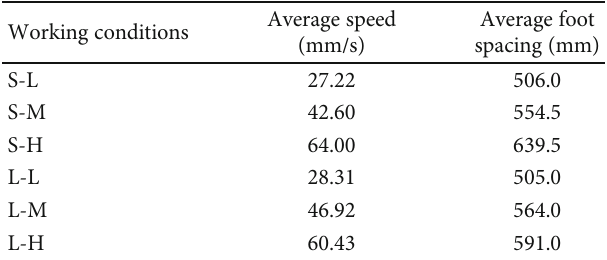
Figure 7: The travelling process of the bionic mechanical foot. (a) Travelling process on solid ground. (b) Travelling process on loose sand. Table 3: Average speed and average foot spacing of the bionic mechanical